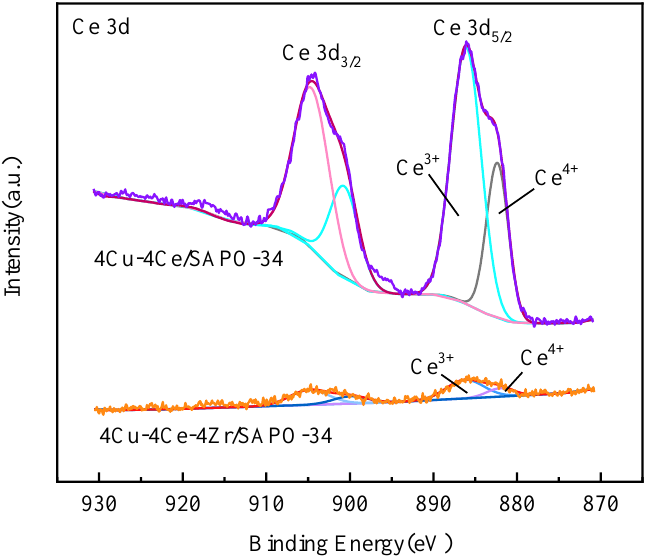
Figure 11. Ce 3d XPS spectra of 4Cu-4Ce-4Zr/SAPO-34 and 4Cu-4Ce/SAPO-34.